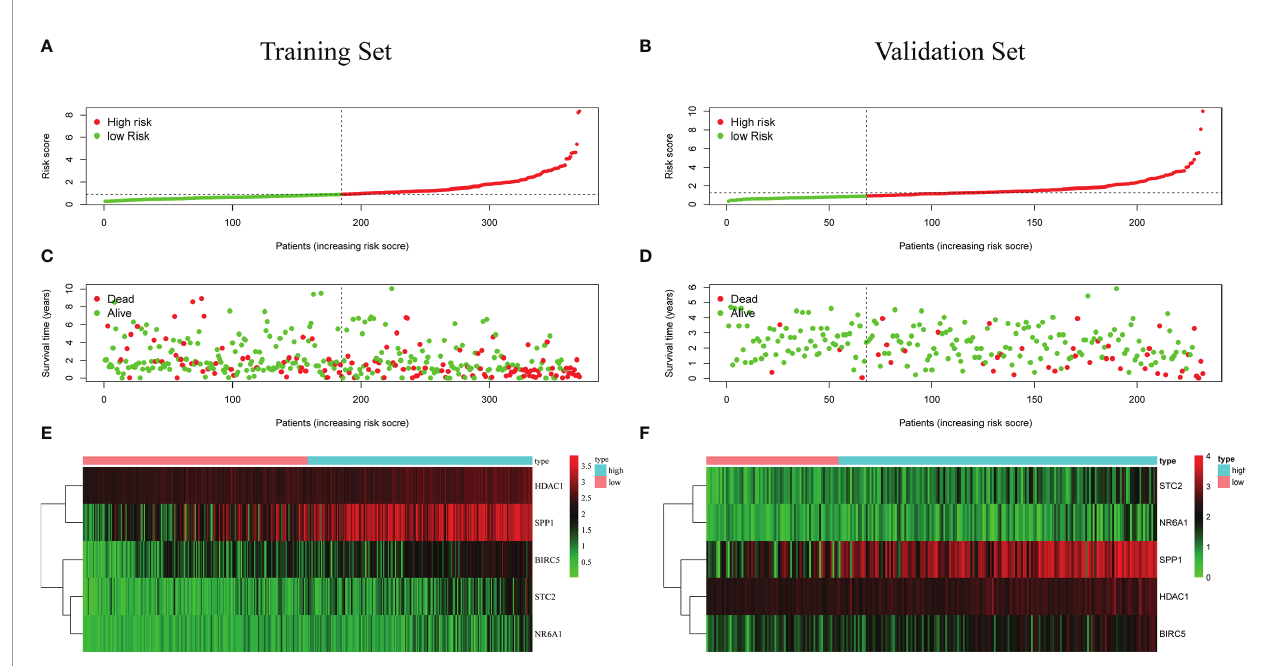
FIGURE 4 | (A, B) Distribution of risk score in patients with hepatocellular carcinoma. The black dotted line serves as the dividing line between the high-risk group and the low-risk group. (C, D) Diagram of the relationship between risk score and patient survival time. (E, F) Heat map of fi ve immune genes in prognostic model, the abscissa represents the sample: the red area is the low-risk group, and the blue area is the high-risk group. The result of (A, C, E) is based on TCGA data (training set), and the result of (B, D, F) is based on ICGC data (validation